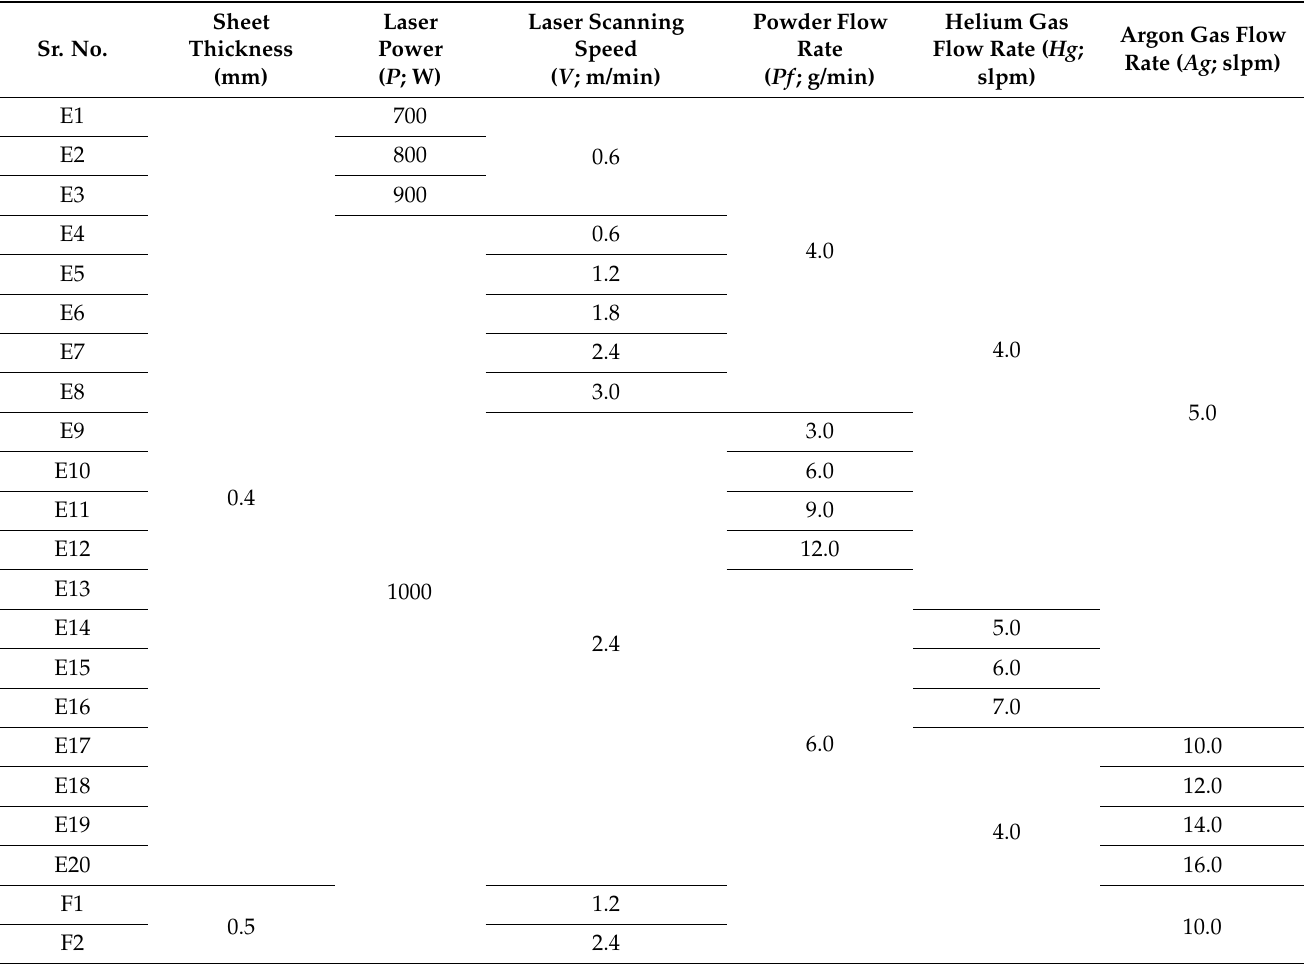
Table 4. Laser welding operating parameters with filler material (Inconel 718).